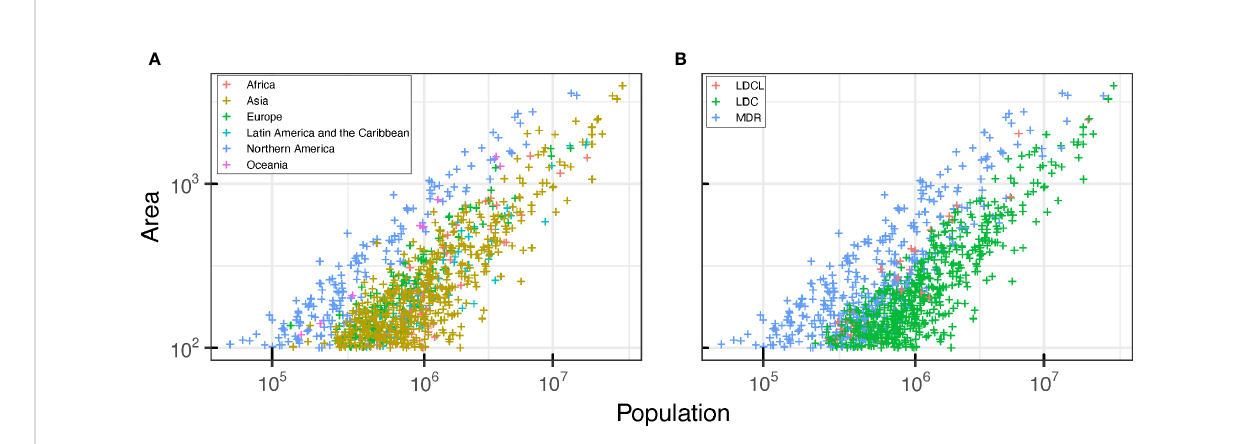
FIGURE 2 A scatter plot of 933 cities in 2015 used in this study colored by geographic region (A) and level of economic development status: LDC = low development countries, LDCL = least developed countries, and MDR = more developed countries (B) . Note that the x and y axes are log10